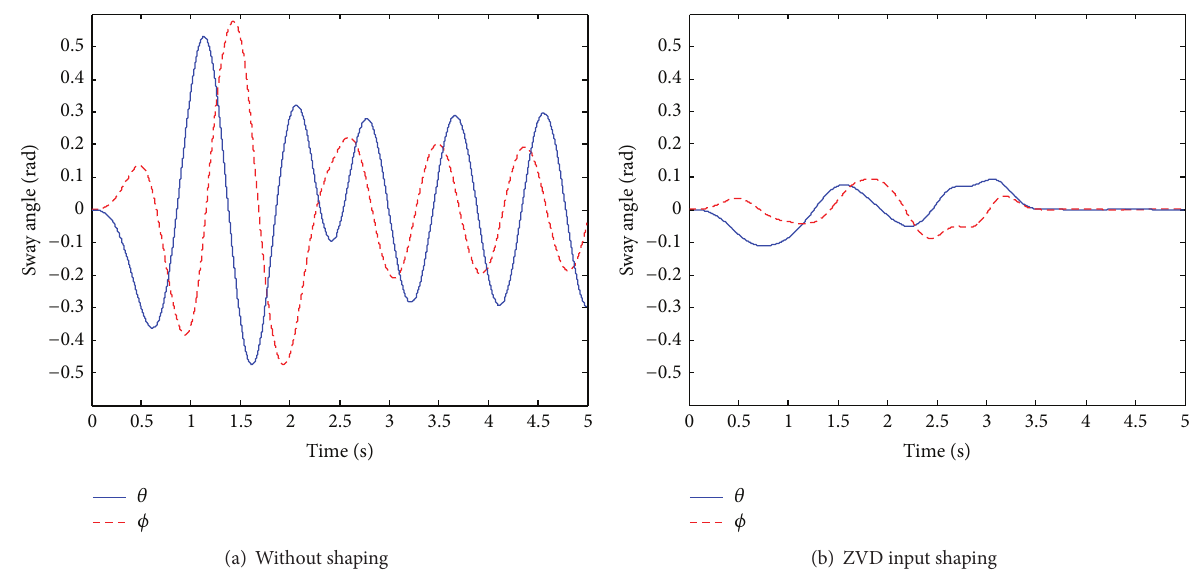
Figure 9: Pendulum sway angles: (a) without shaping (b) with ZVD